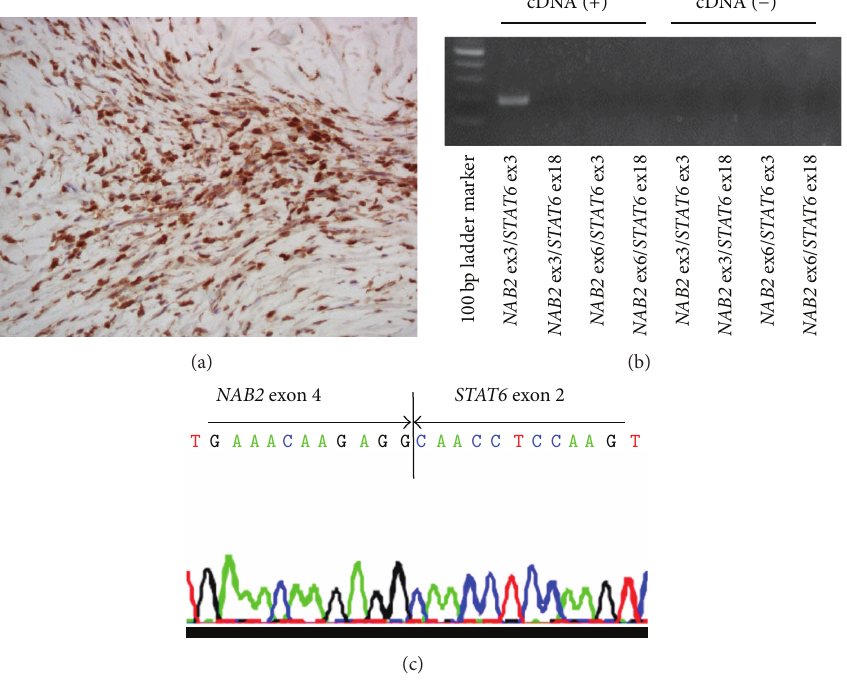
Figure 3: (a) Immunohistochemically, STAT6 was highly expressed in the nuclei of the spindle cells. The results of (b) RT-PCR and (c) sequencing analysis indicated that NAB2 exon 4 fused to STAT6 exon 2.